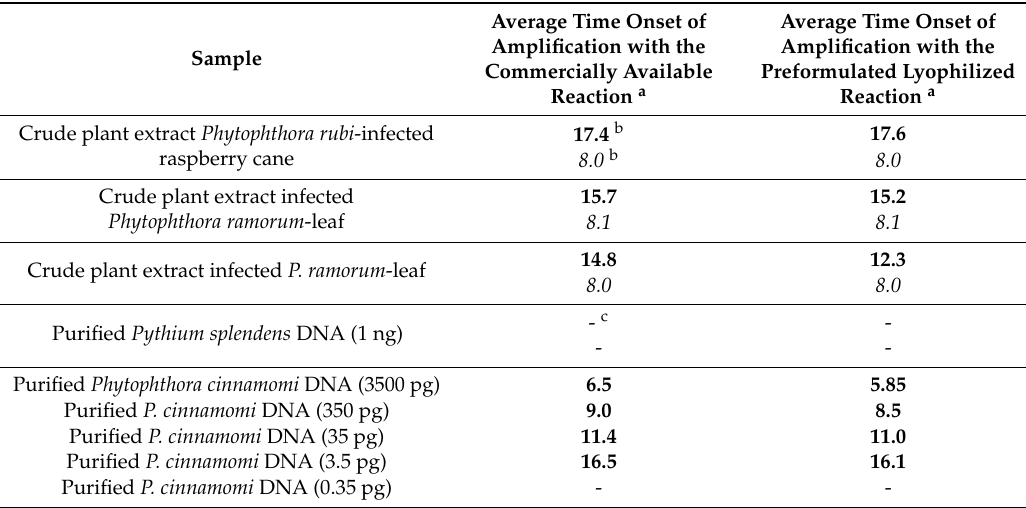
Figure 3. All necessary reagents to run the lyophilized RPA assay. ( A ) Crude extract produced with diseased plant sample and GEB2 buffer within an Agdia mesh bag. ( B ) Sterile water. ( C ) Magnesium acetate to initiate the reaction. ( D ) Rehydration buffer. ( E ) Preformulated lyophilized RPA reagents in pre-loaded tubes (TwistDX, Cambridge, UK). Table 1. Comparison of recombinase polymerase amplification (RPA) assays using commercially available kits requiring addition of primers and probes and preformulated kits with the primers and probes lyophilized with the reaction mixture. Recombinase polymerase amplification using primers and probes for Phytophthora genus-specific detection and a plant internal control reported by Miles et al. [20]. Data collected with an Axxin T16-ISO platform.